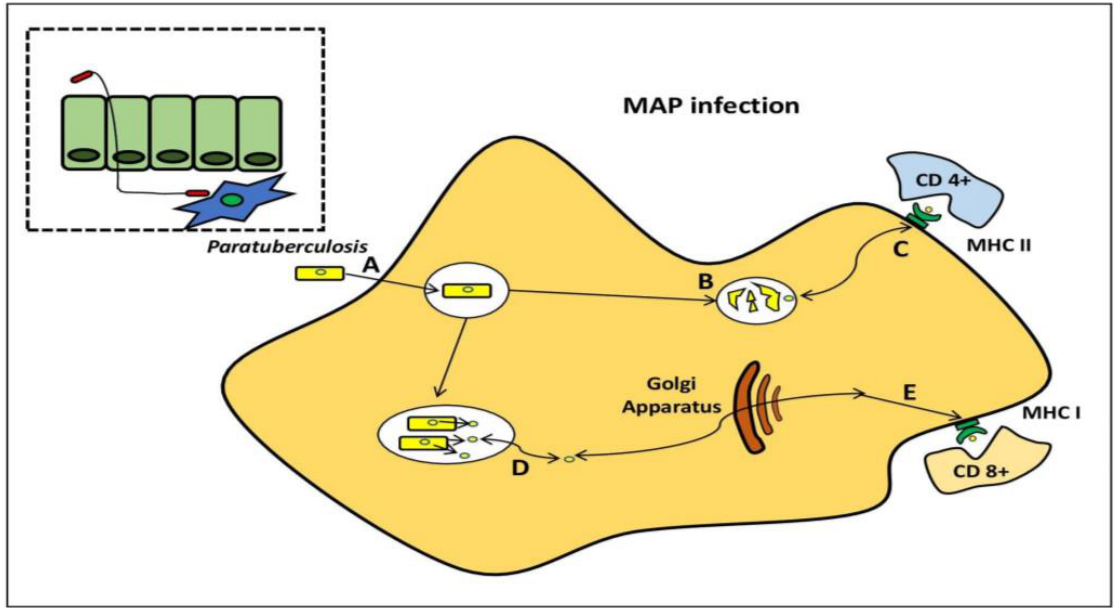
Figure 5. Mycobacterium avium subspecies paratuberculosis within the macrophage. MAP bacilli pass by the mucosal barrier, preferentially via M cells, and after which it is engulfed by sub-epithelial macrophage (A). MAP bacilli degrade within the phagosome (B) and also stimulateCD4+ immune responses via antigen presentation through the MHC class II pathway. (C) MAP evades destruction within phagosome through the inhibition of general killing mechanisms and proliferates. (D) MAP proteins are secreted from the phagosome to the cytosol and are subsequently available for presen- tation to (E) CD8+ immune responses via the MHC class I pathway.